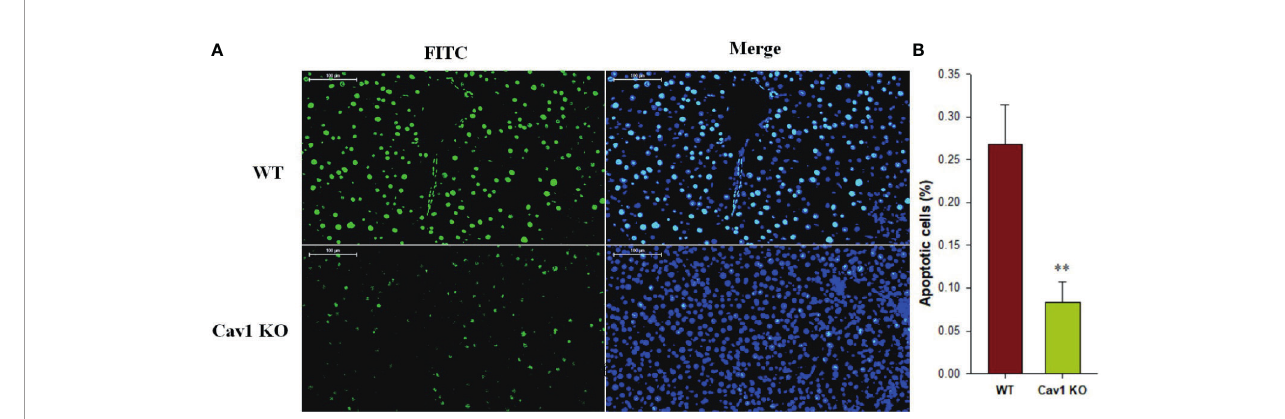
FIGURE 2 | Cav1 de fi ciency reduced hepatocellular apoptosis in CCl 4 -induced acute liver injury. (A) The effect of Cav1 de fi ciency on CCl 4 -induced apoptosis in the liver was explored by TUNEL staining. Nuclei were counterstained with DAPI (blue) and apoptotic cells were detected by TUNEL (green). (B) Quantitative analysis of apoptosis in injured livers. Signi fi cantly decreased apoptosis was observed in the liver of Cav1 KO mice compared to the WT group at 2 weeks after CCl 4 treatment. Data are shown as mean ± SD, ** p < 0.01 compared with WT mice. Scale bar = 100 µm. n=6 per group.